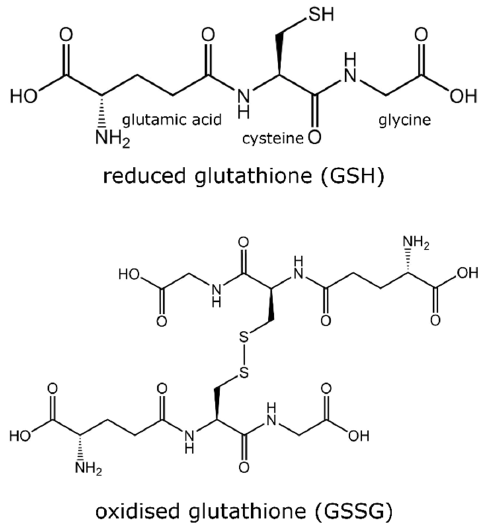
Figure 1. Chemical structure of two isoforms of glutathione (GSH and GSSG).